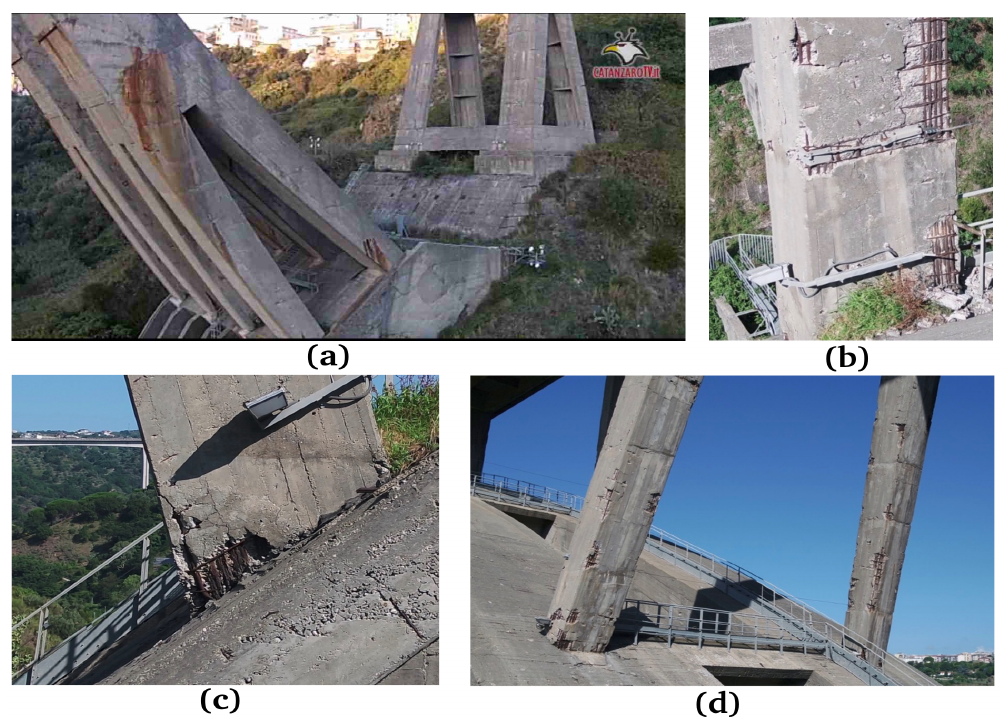
Figure 19. Optical particulars of the “Bisantis” bridge structure: ( a ) Particular 1 of Figure 17, ( b ) Particular 2 of Figure 17, ( c ) Particular 3 of Figure 17, ( d ) Particular 4 of Figure